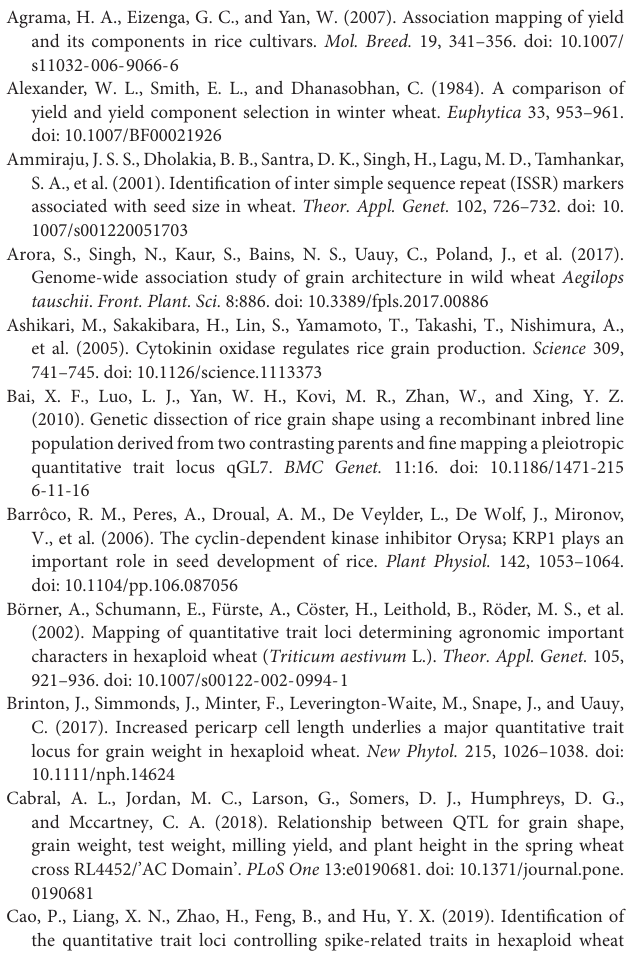
Supplementary Table 11 | The physical location information of the detected major